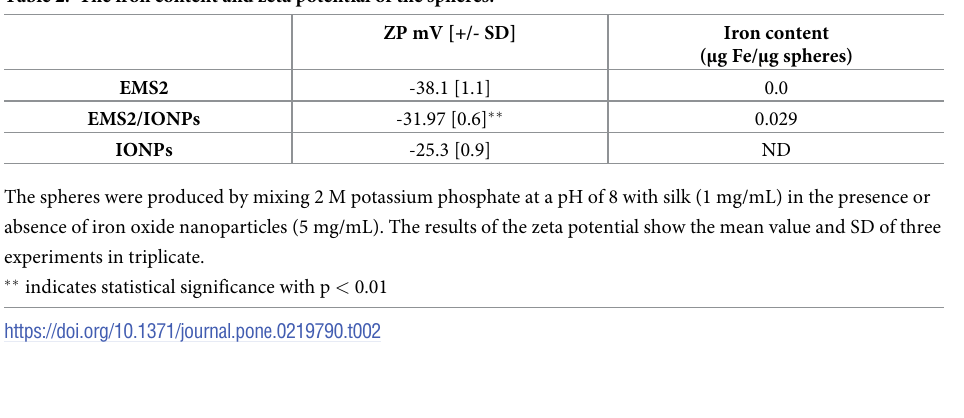
Table 2. The iron content and zeta potential of the spheres.